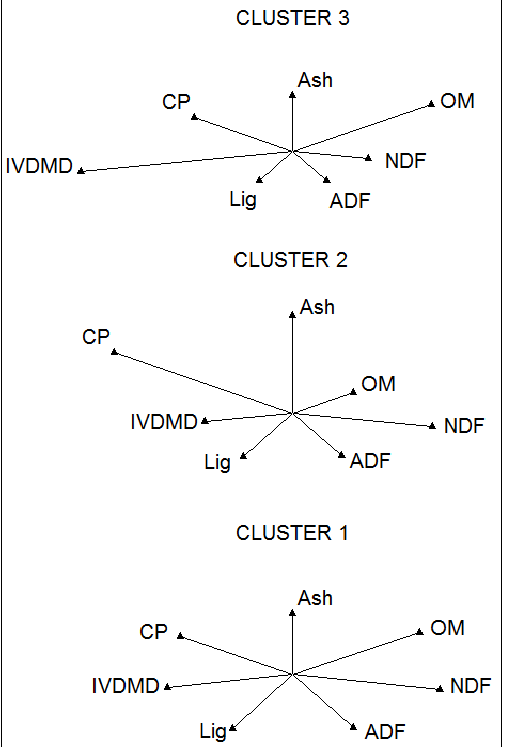
Figure 3. Star graph of the behavior of the nutritional quality variables of the plants assigned to each cluster. OM: organic matter; NDF: neutral detergent fiber; ADF: acid detergent fiber; Lig: